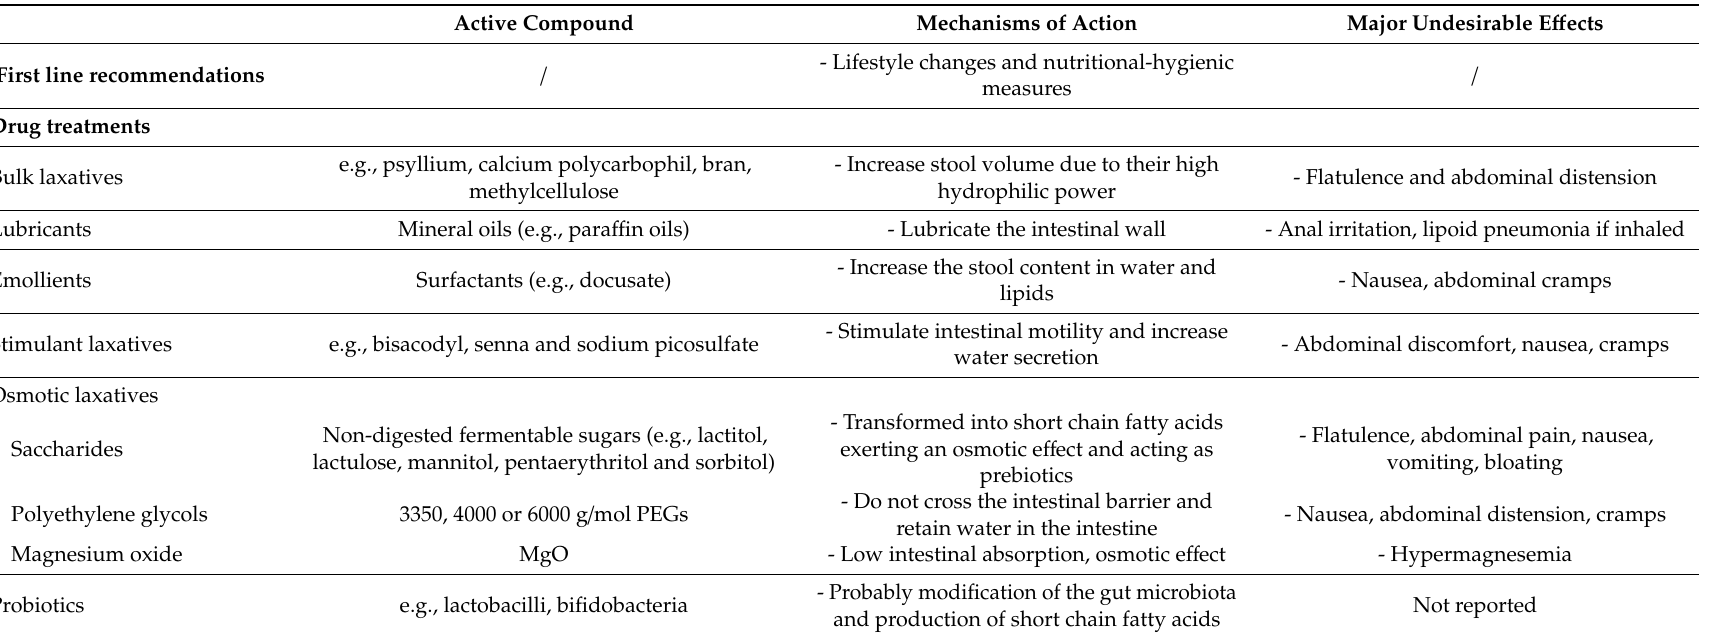
Table 2. Summary of the current treatments for functional